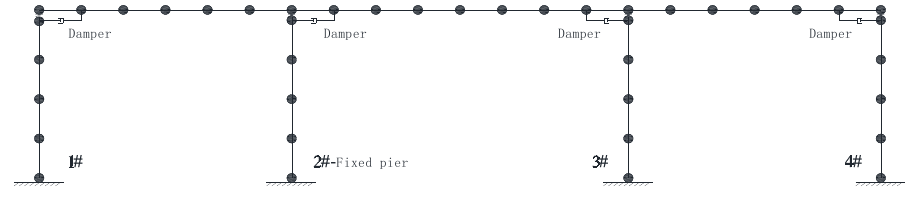
Figure 2. Schematic diagram of the finite element model.